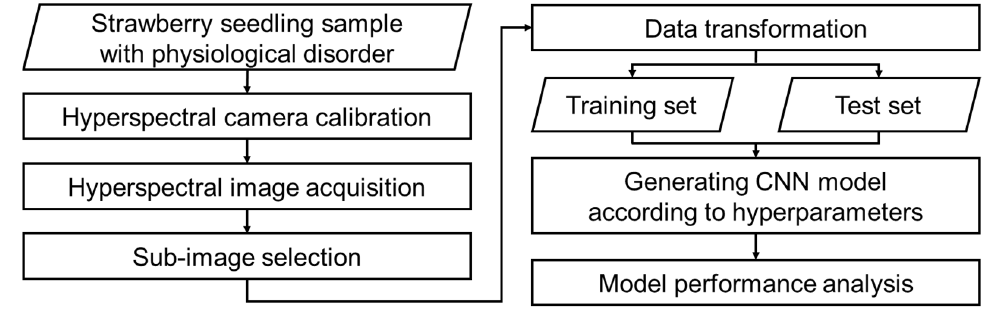
Figure 3. Overall workflow for data processing and analysis.